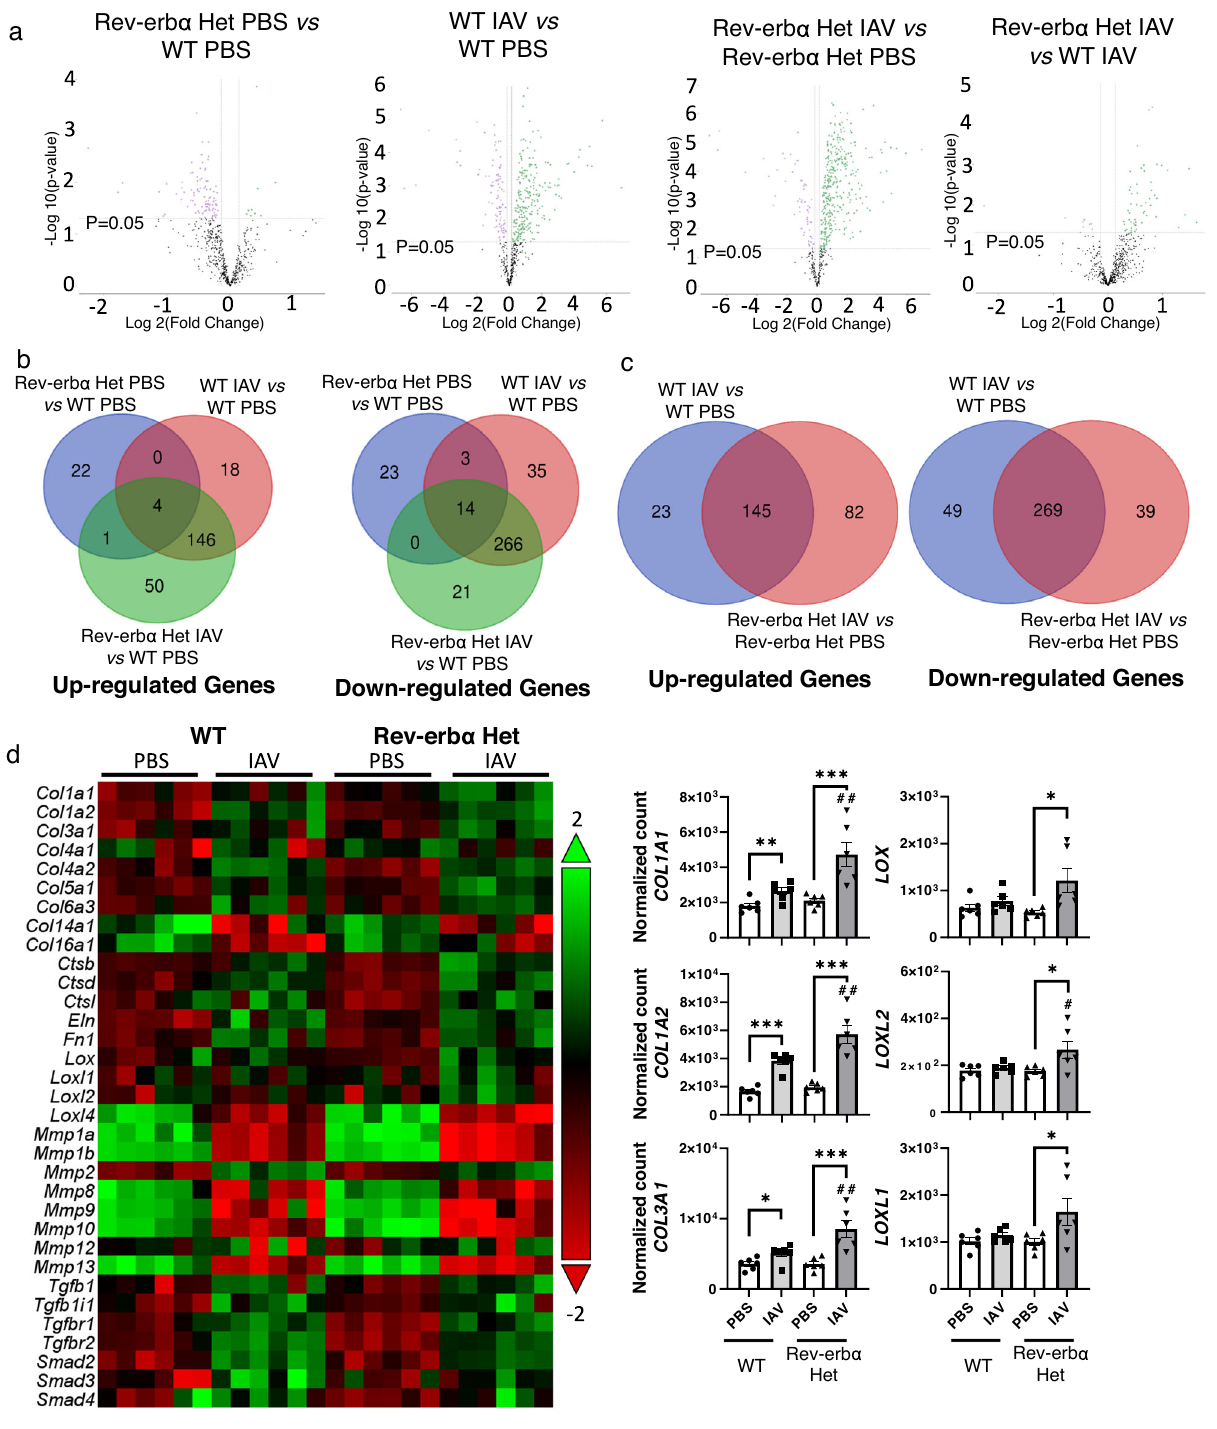
Fig. 6 | IAV infection induced dysregulation of pro fi brotic gene expression exacerbated inRev-erb α Hetmice. WT and Rev-erb α Het mice(equal number of male and female mice) were dosed with IAV (10 3 PFU) for 15 days, and lungs were homogenized for RNA isolation. Gene expression analysis was conducted using nCounter Fibrosis Panel via nCounter SPRINT Pro fi ler. RNA expressions were nor- malized and analyzed via nSolver software and ROSALIND service. a The dysre- gulatedgeneexpressionsbetweengroupswereshownasvolcanoplots,thecutoff fi lter is atleast 10% change (up or downregulation), and p <0.05. b , c Overlapping